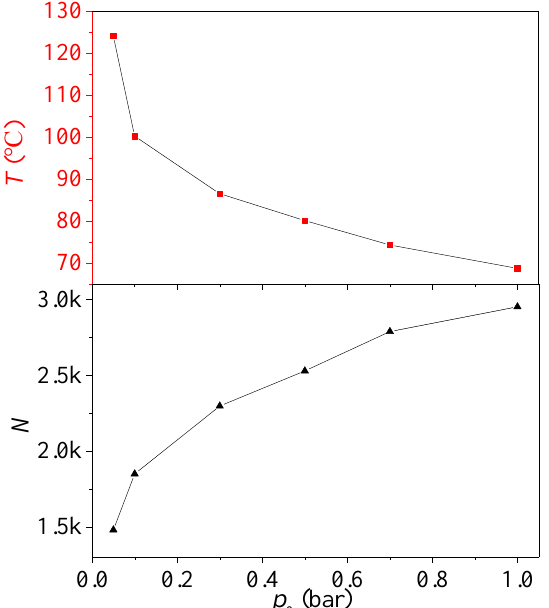
Figure 13. Effects of the ambient pressure on the thermal fatigue lives of the key solder joints and the maximum temperature of the key solder joints at the time t = 7 min.